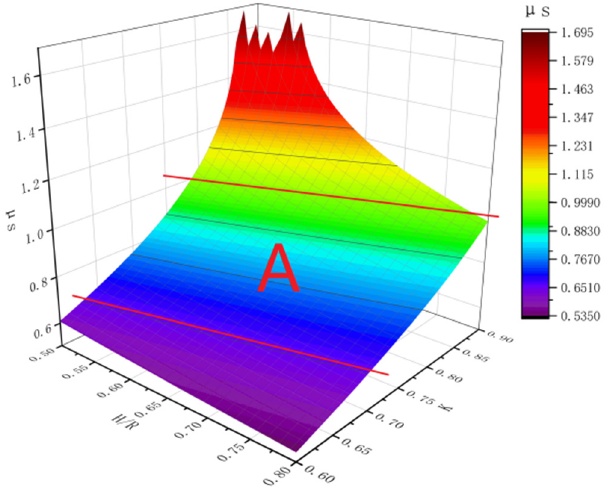
Figure 6. Relationship between the minimum static friction coefficient and the maximum climbing stair aspect ratio and eccentricity